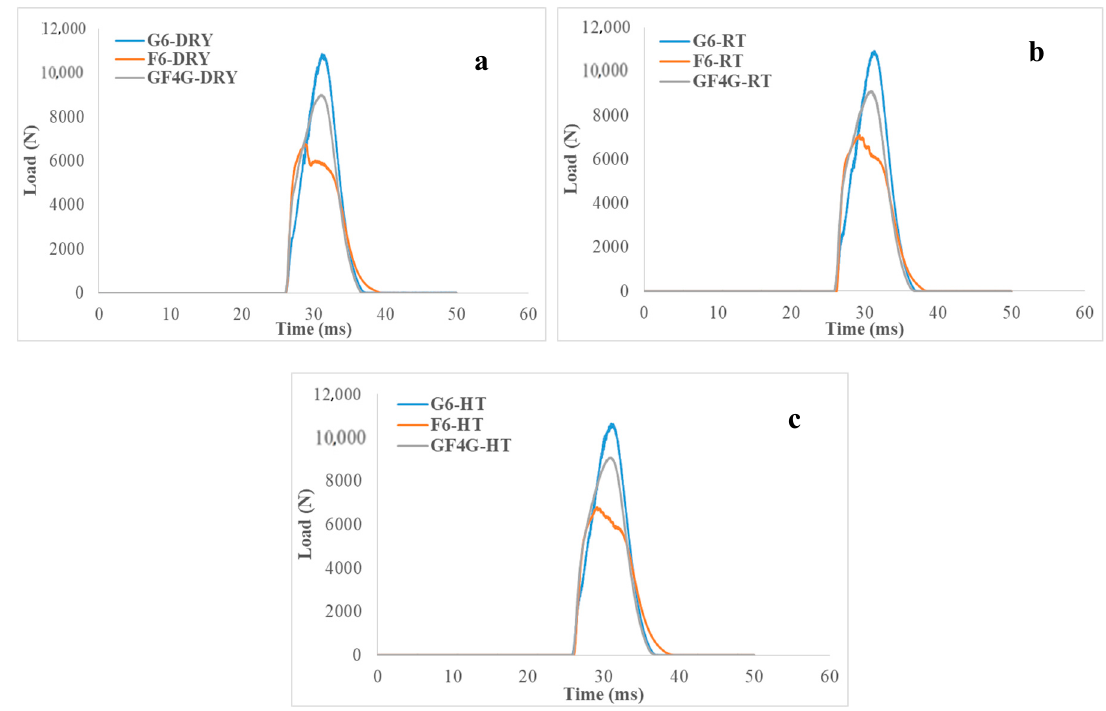
Figure 3. Load versus time traces for ( a ) dry samples, ( b ) room temperature wet samples and ( c ) high temperature wet samples. Table 3. Maximum load and maximum time of dry samples, RT, and HT wet samples.